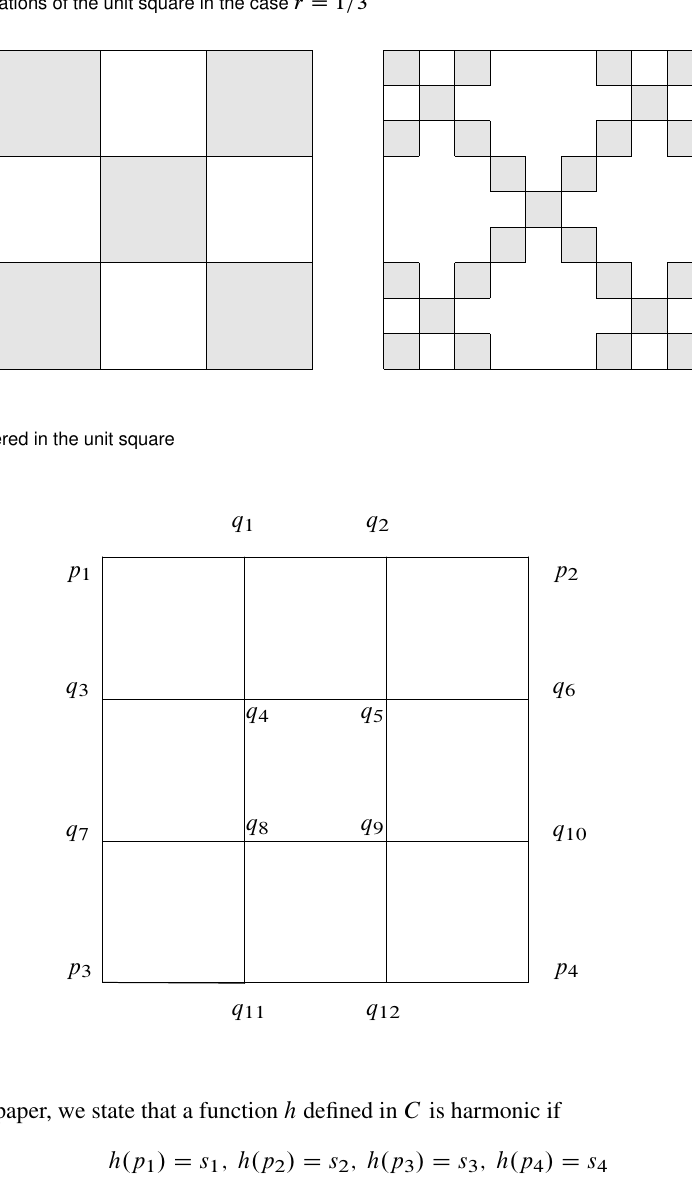
Fig. 2. The two first iterations of the unit square in the case r D 1=3